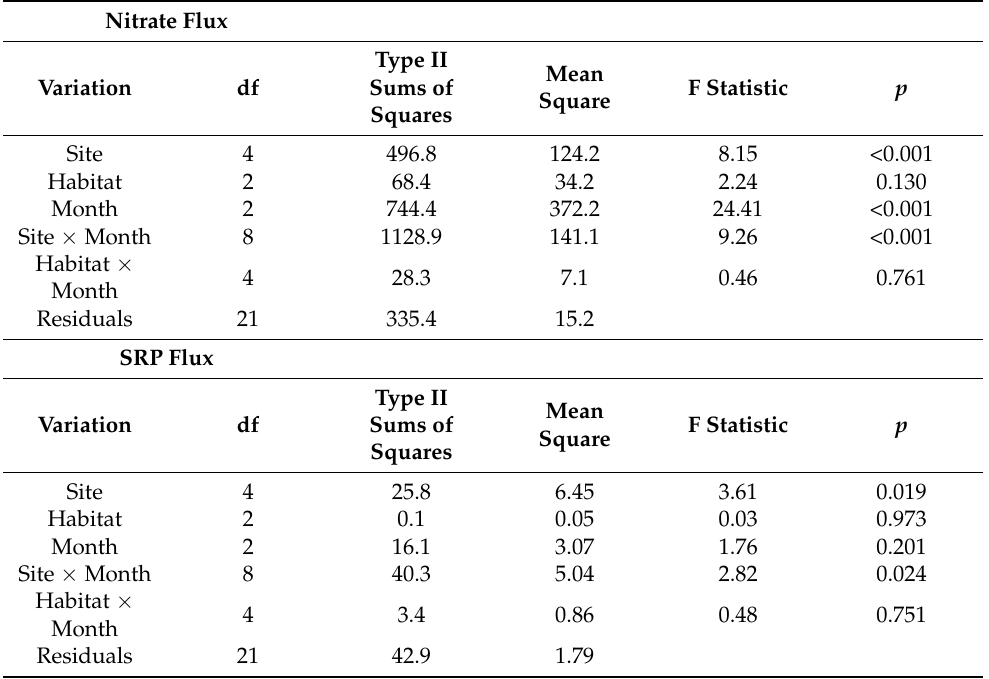
Table 1. Spatial assessment of sediment nitrate and soluble reactive phosphorus (SRP)h uptake rates comparing sites, depth habitat (mid-lake, bald cypress ( Taxodium distichum (L.) Rich.) tree edge, shore), and month. Significant p -values are in